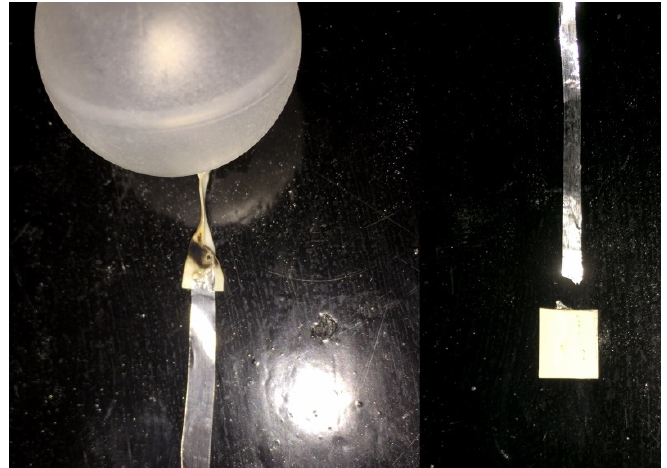
Figure 12 . The damage to the flight train model due to the exit and entry of the discharges.